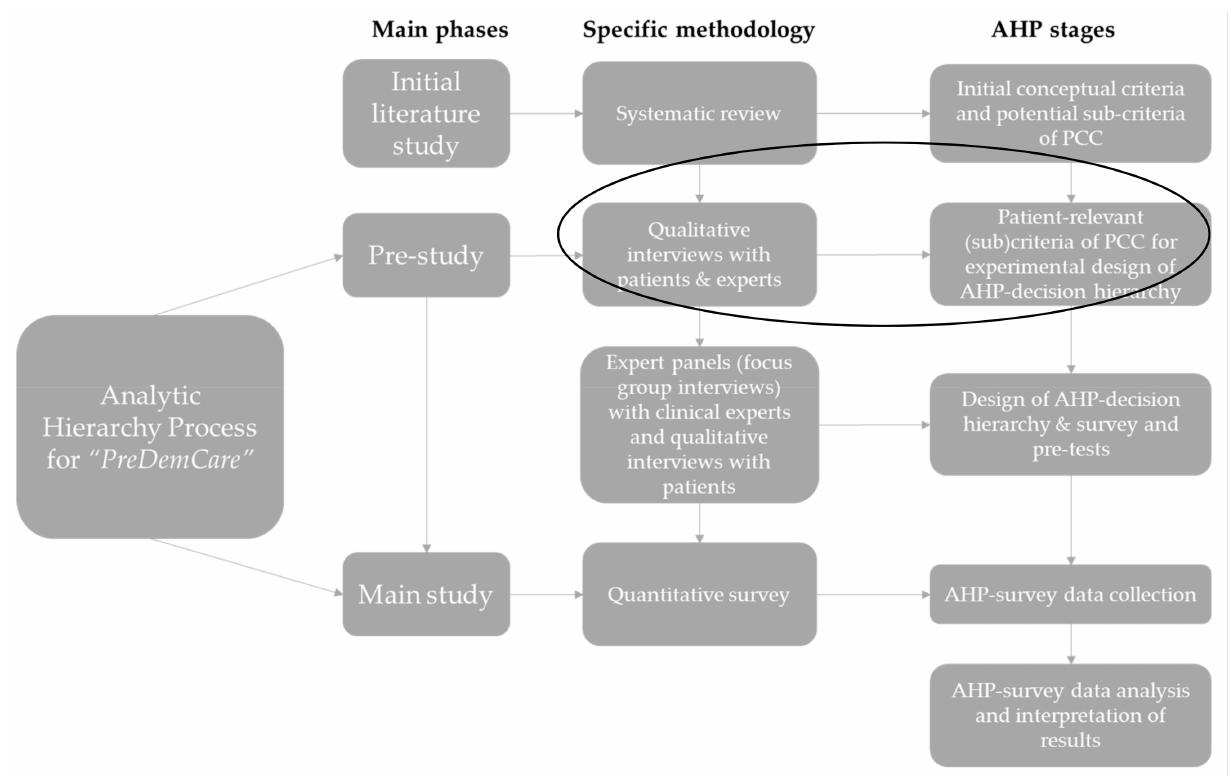
Figure 1. The mixed-methods design of the AHP for PreDemCare (own illustration inspired by [28]). Note: The initial literature study refers to a previously conducted systematic review [36]. AHP survey data will be analyzed with the principal right eigenvector method following Saaty [37]. Abbreviations: AHP = Analytic Hierarchy Process, PCC = person-centered